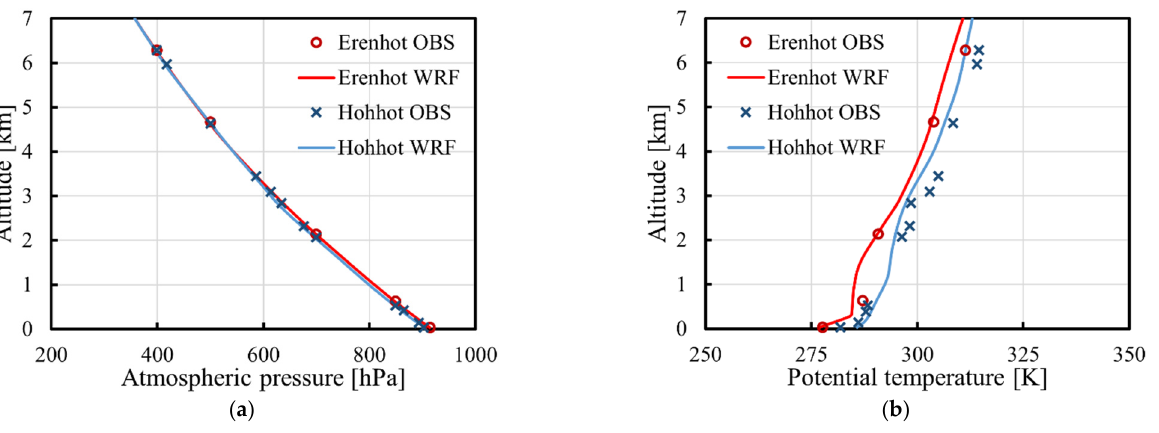
Figure 3. Profiles of ( a ) atmospheric pressure and ( b ) potential temperature above the main landing area from WRF and observations at 00:00 LST on 17 October 2005.